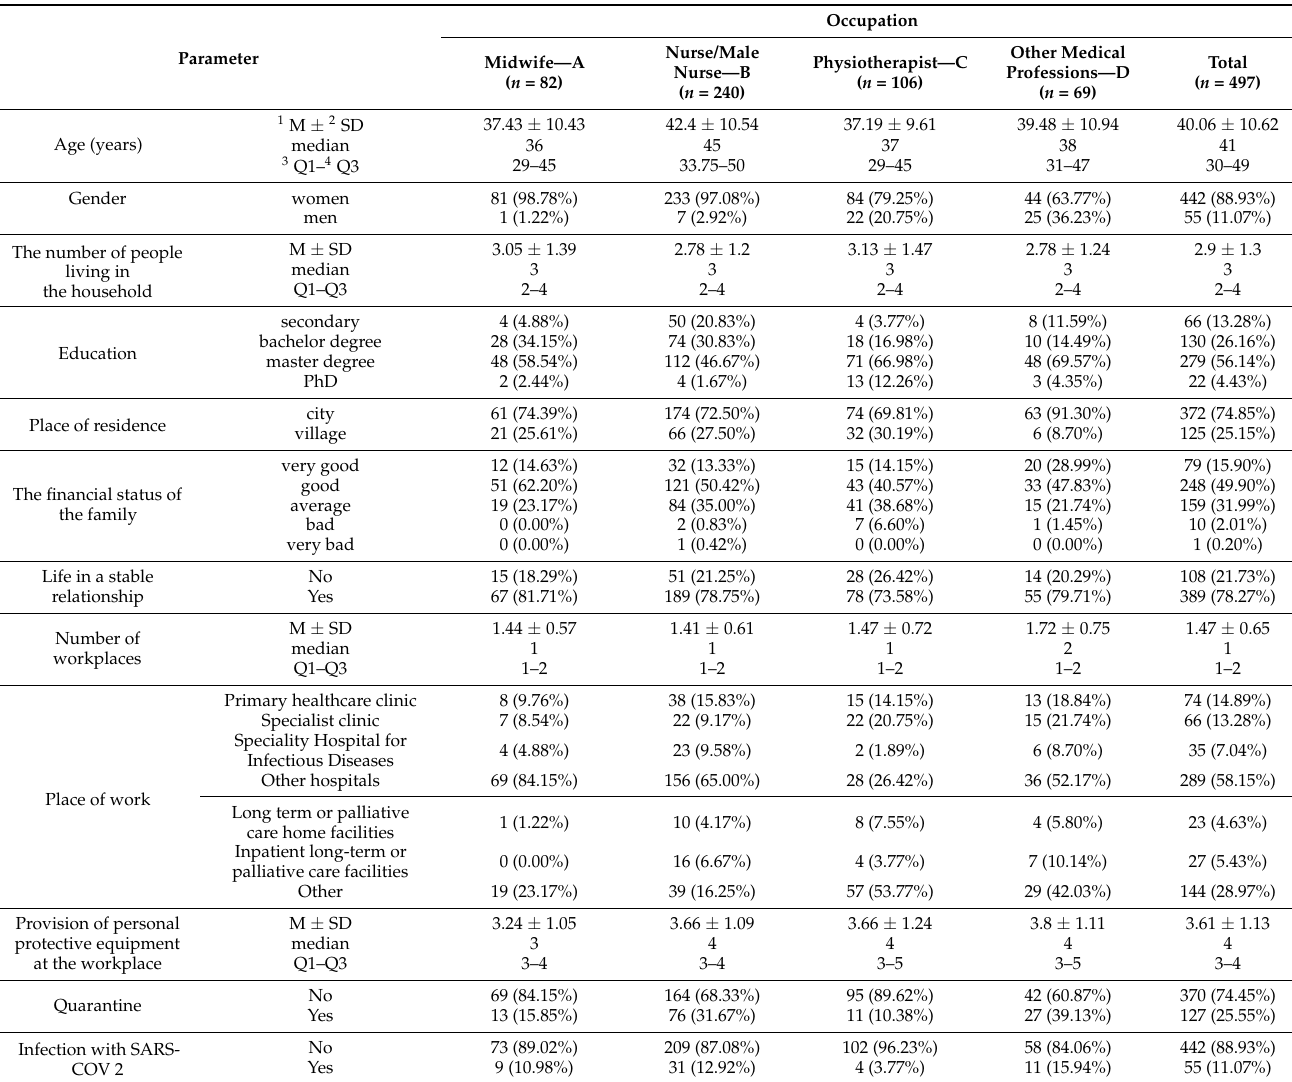
Table 1. The characteristics of the